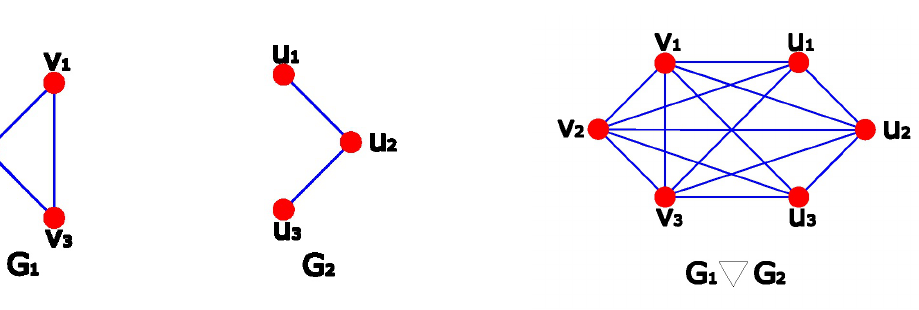
Figure 4.1 Join of two